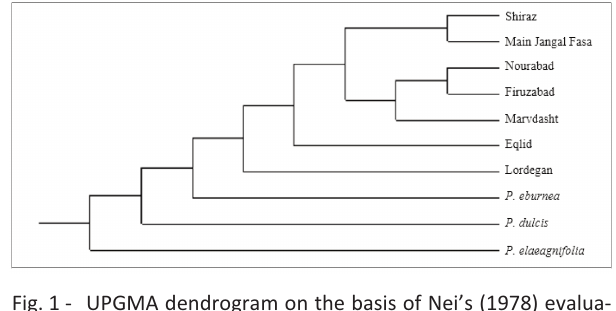
Fig. 1 ­ UPGMA dendrogram on the basis of Nei’s (1978) evalua­ tion of genetic distance among 10 populations of almond.